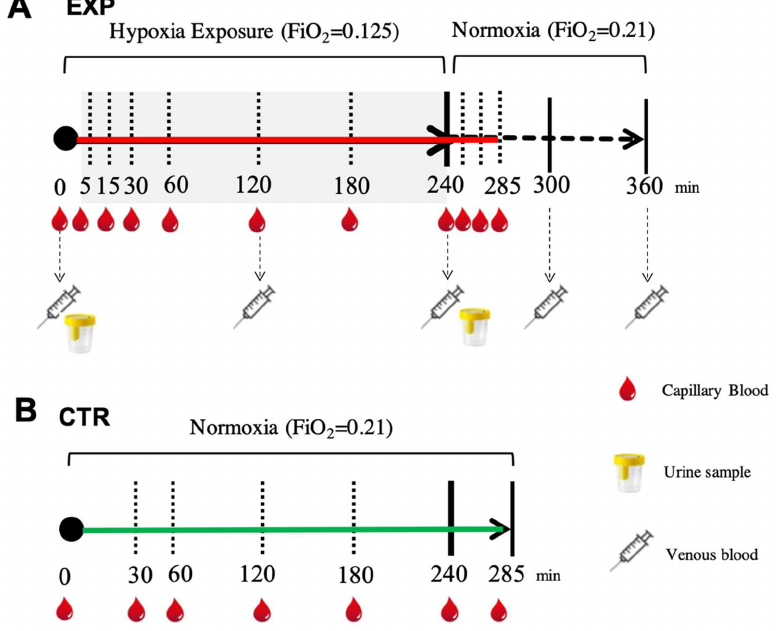
Figure 4. ( A ) EXP. Experimental timeline adopted for collecting each subject’s blood sample (capillary (red drops), venous (syringes)) to measure ROS production by EPR, oxidative damage (PC and TBARS) by enzymatic assays and urine (glasses) to assess urinary 8-OH-dG and 8-iso-PGF2 alfa by ELISA. ( B ) CTR. Experimental timeline (continuous green line) adopted for collecting capillary blood samples (red drops) to measure ROS production by EPR.